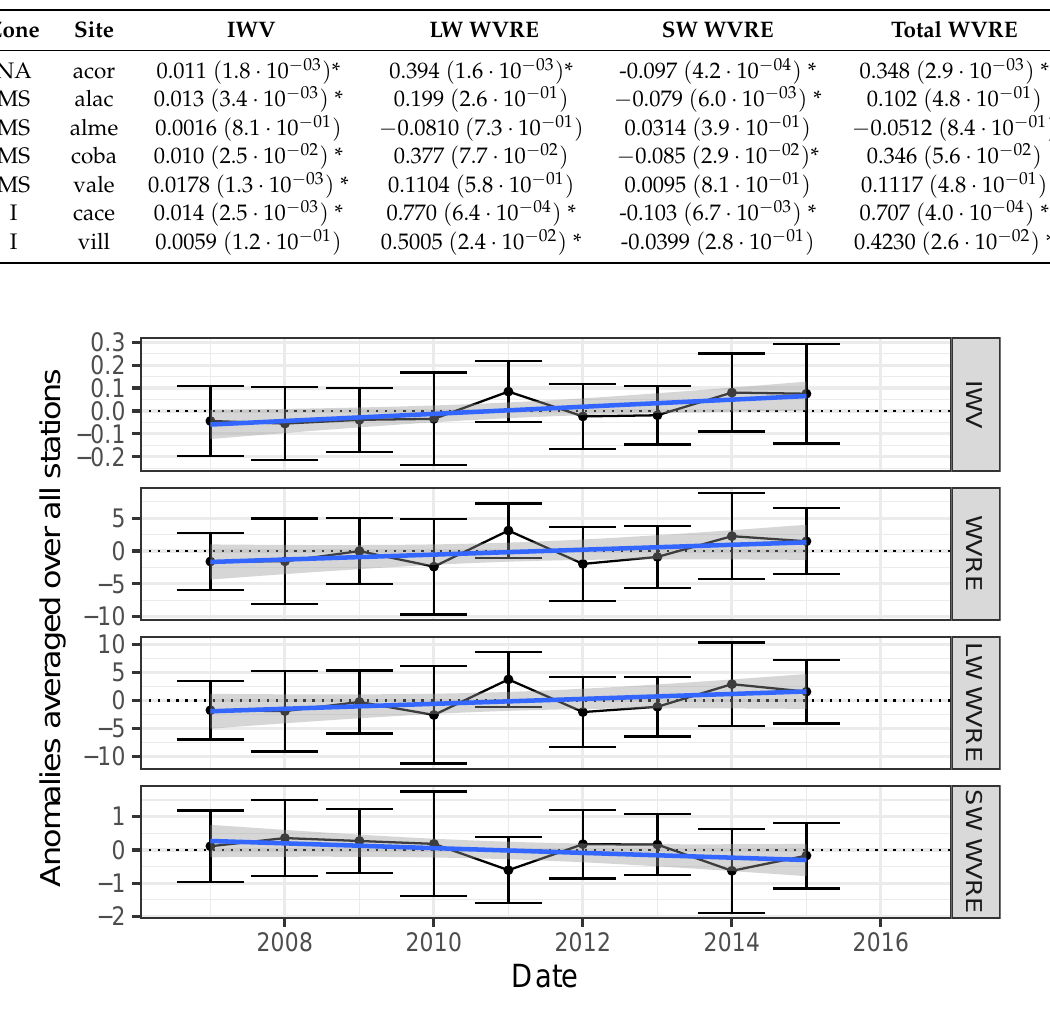
Figure 3. Time-series of station-averaged integrated water vapor (IWV) and WVRE (SW, LW and total regimes) anomalies. Values are in cm for IWV and in Wm − 2 for WVRE. Blue solid lines point out the linear trends (see